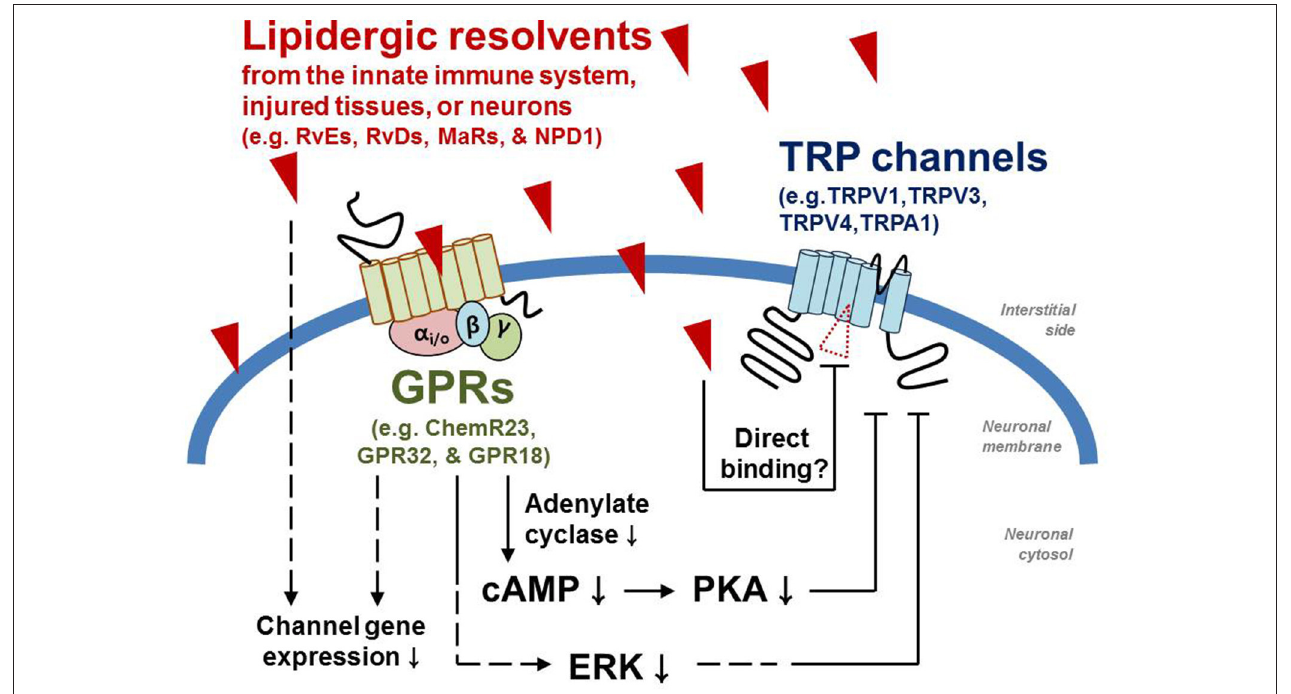
FIGURE 1 | Molecular modes of action by which pro-resolvents inhibit TRP channels. Dotted lines indicate that other unknown signaling components may take part during the pathways.